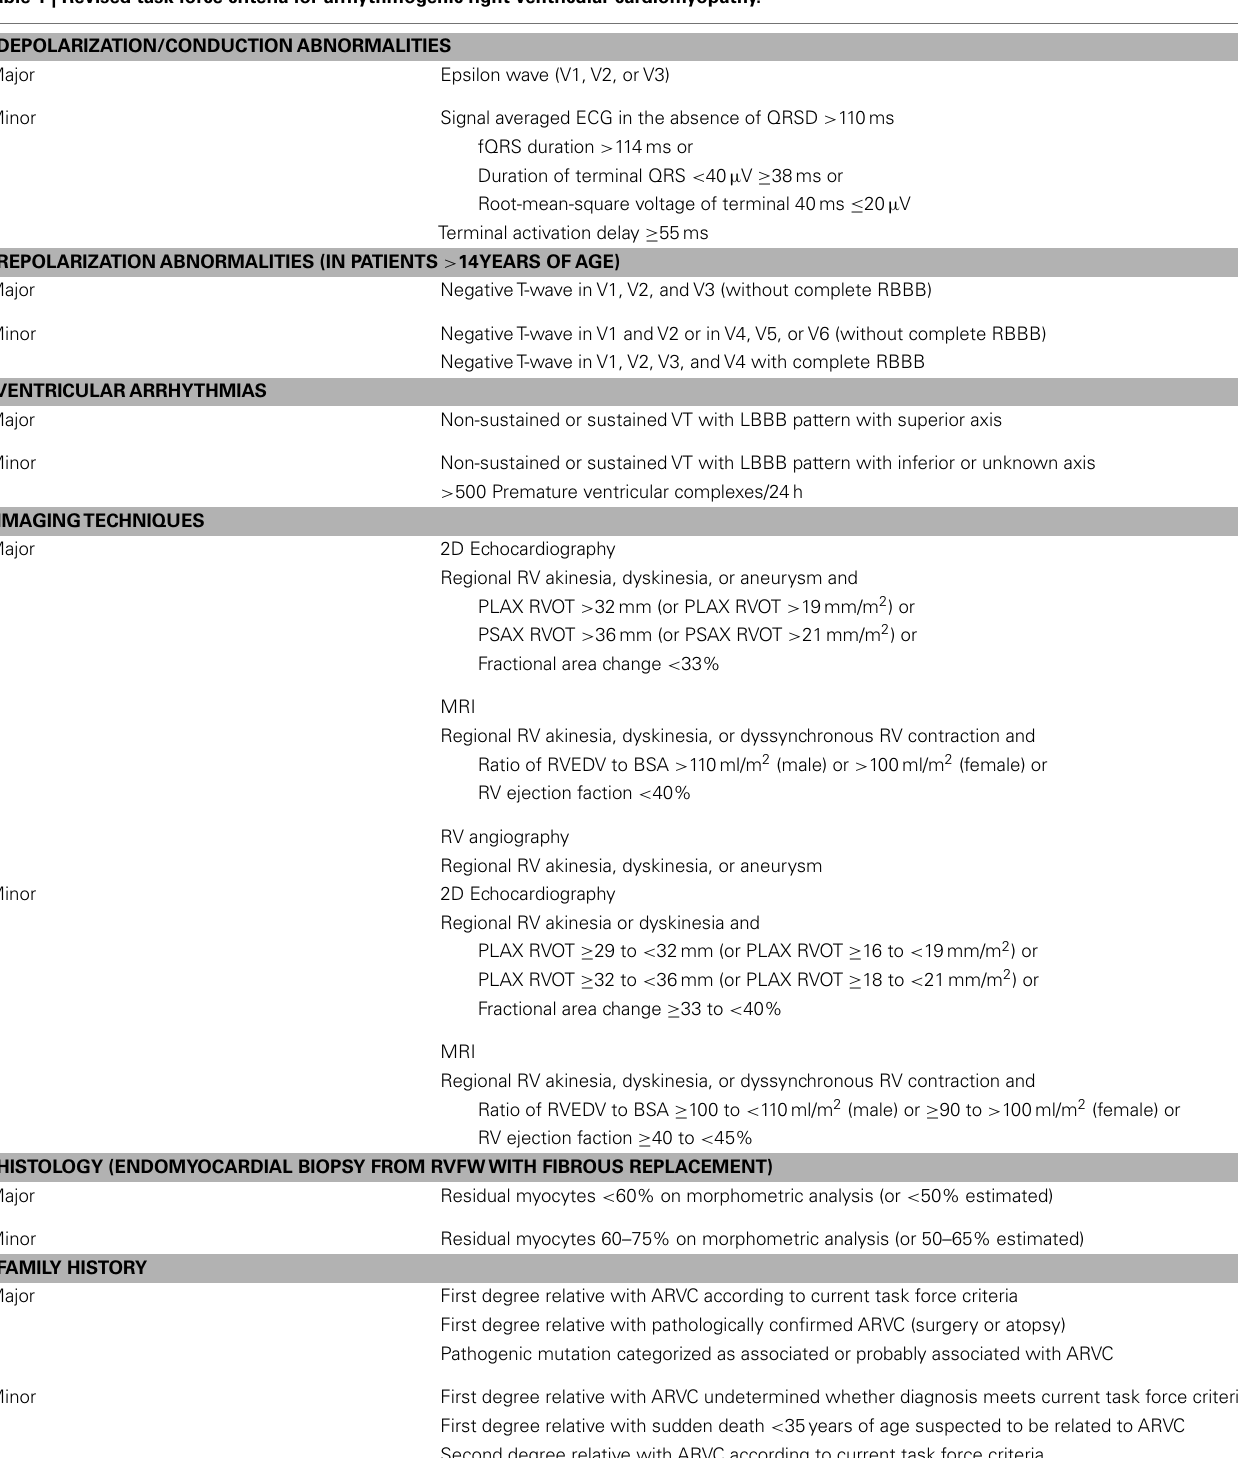
Table 1 | Revised task force criteria for arrhythmogenic right ventricular